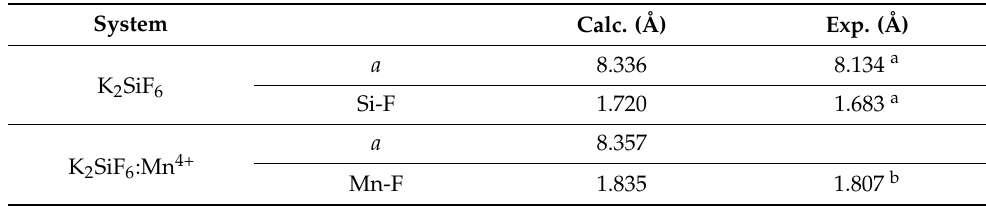
Table 1. Comparison of lattice constants, a , and bond lengths of Si–F and Mn–F in the non-doped and Mn 4+ -doped K 2 SiF 6 , respectively, between experiments and